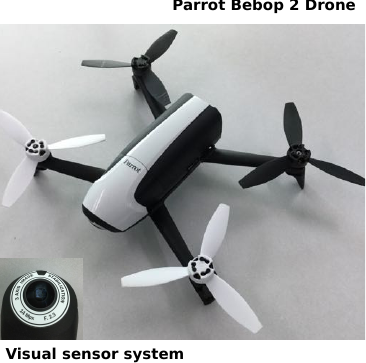
Figure 5. Parrot Bebop 2 Drone with a 14-Mpx flight camera. In the bottom-left corner, we show its visual sensor system.